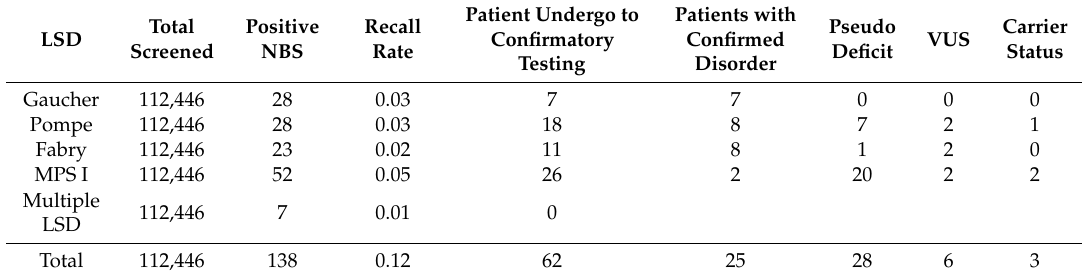
Table 1. Newborn screening results, recalls and confirmed